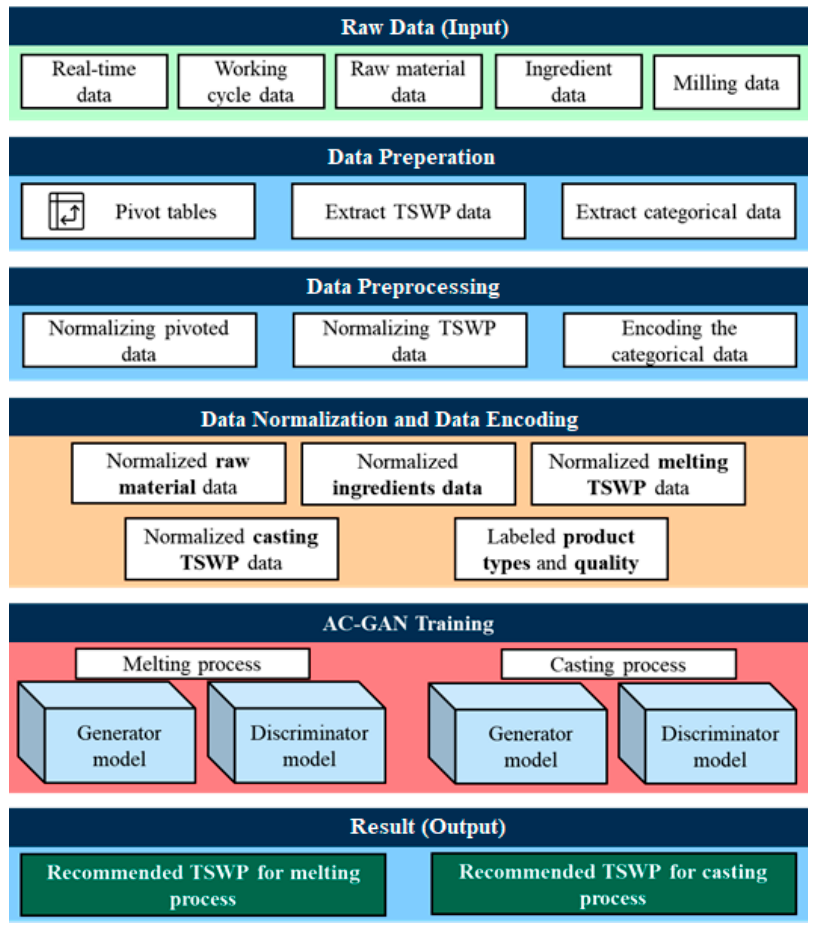
Figure 2. Overall process of the proposed